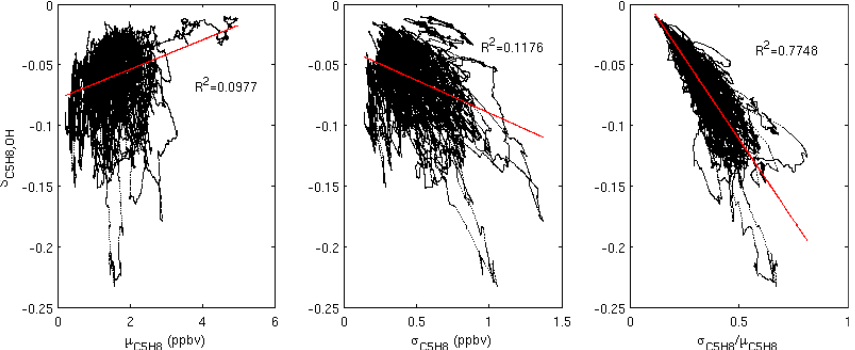
Fig. 7. Correlations between S C and the mean isoprene concentration (left panel), standard deviation of isoprene concentration (centre 5 H 8 , OH panel), and relative deviation (right panel). Values between 10:00–16:00LT are used and t s =10min.